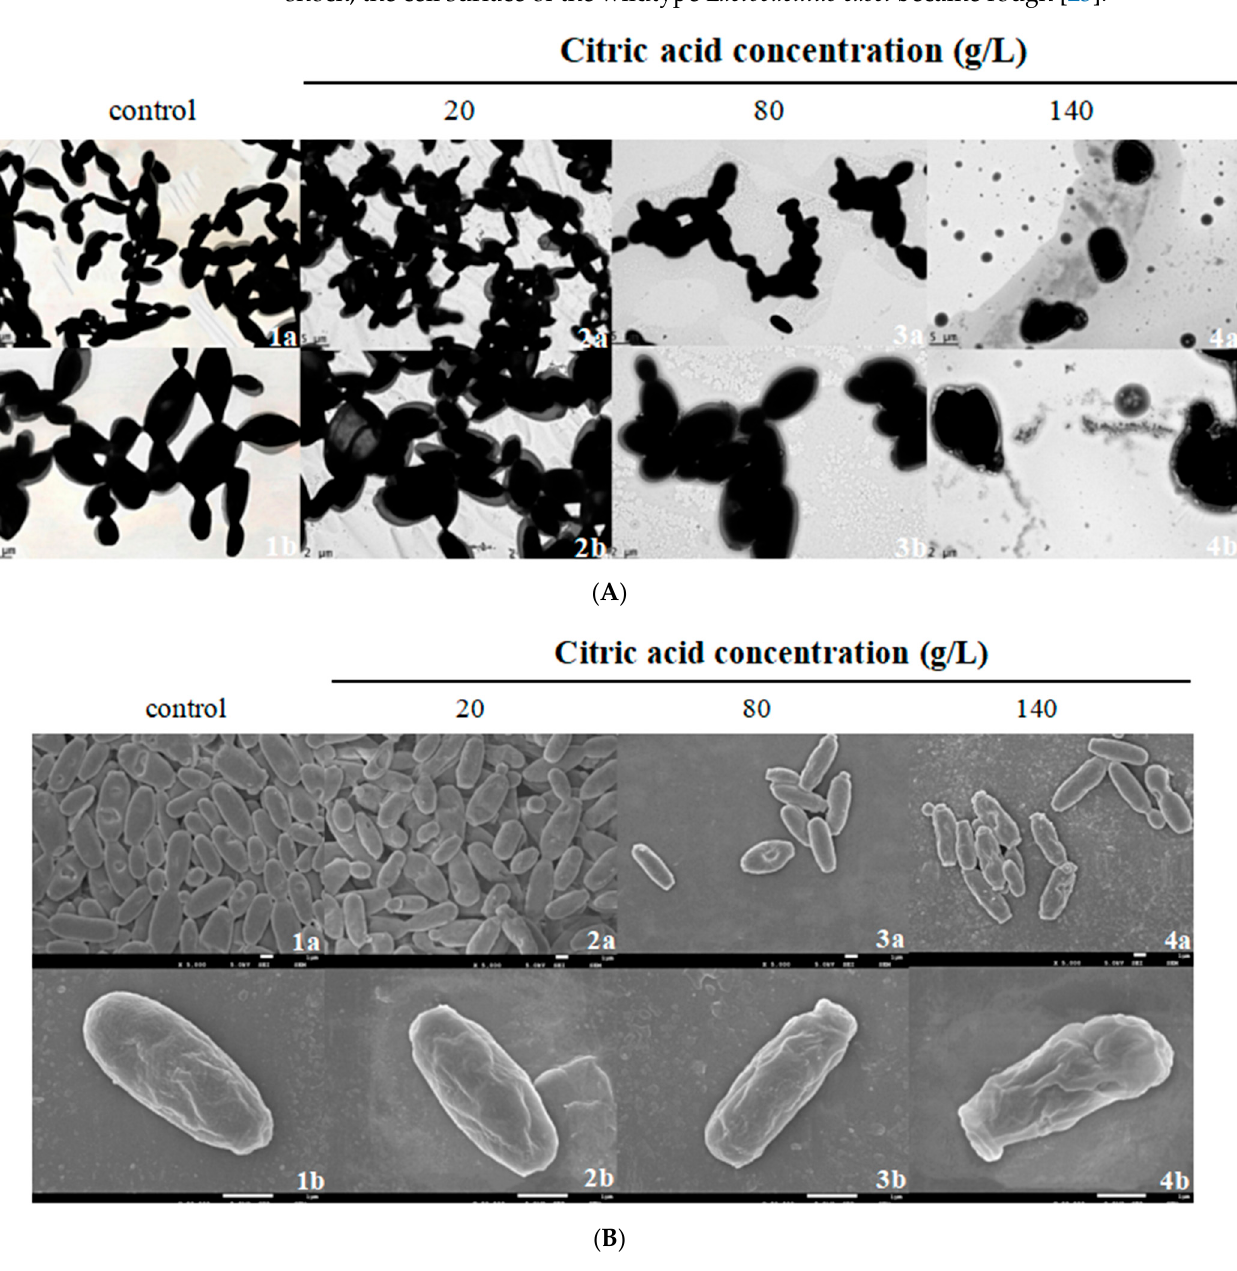
Figure 1. TEM and SEM images of extracellular morphology of I. terricola WJL G4 under different citric acid concentrations. Letters correspond to: ( A ): TEM images; ( B ): SEM images; 1, 2, 3, and 4: control, 20, 80, and 140 g/L citric acid; a: ×5000; b: ×20,000.